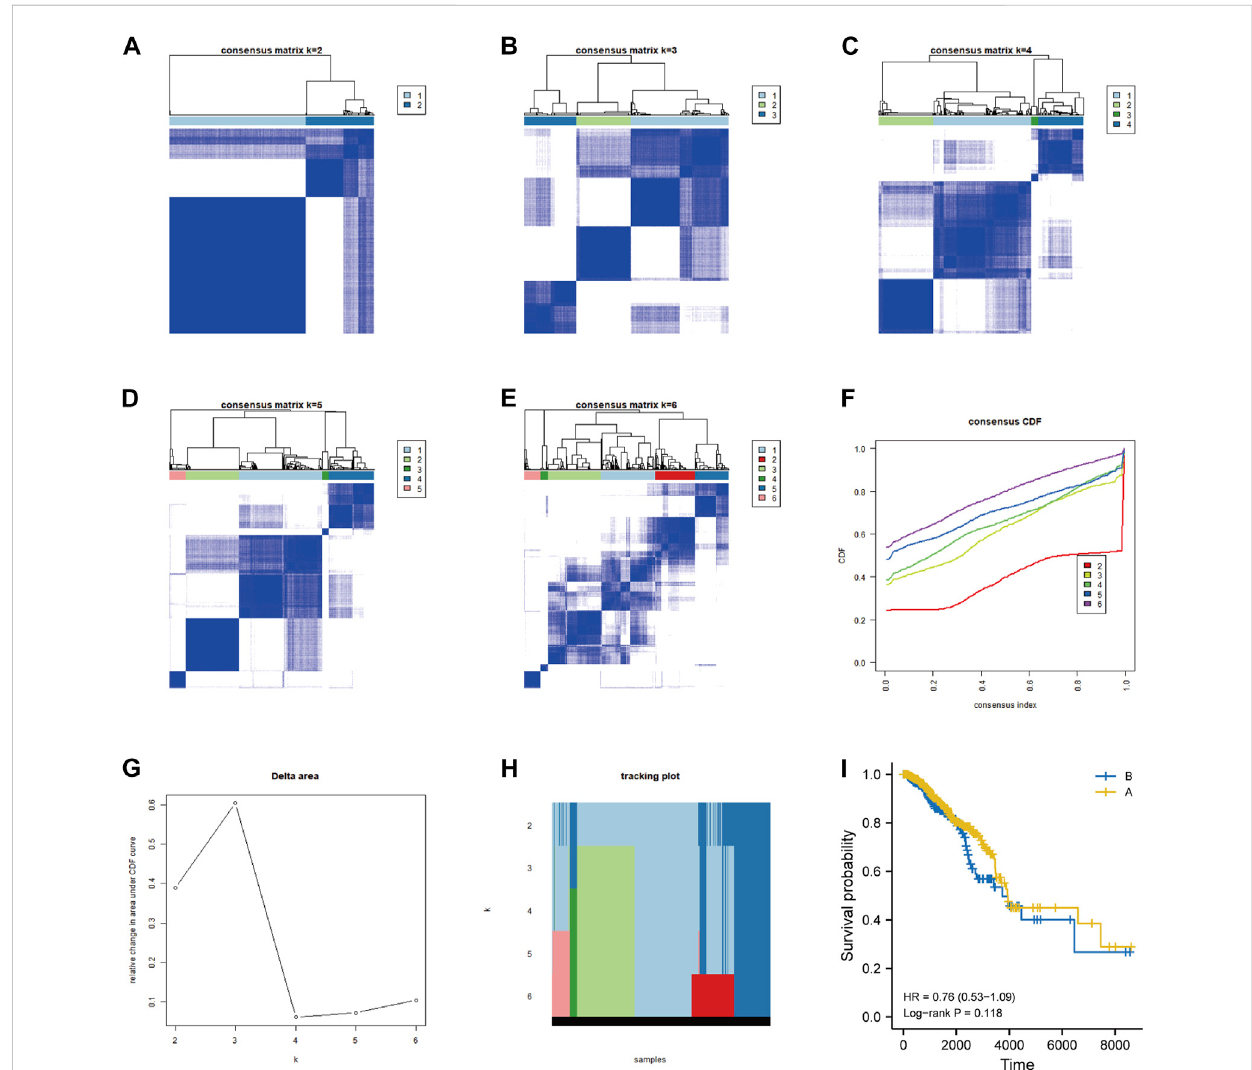
FIGURE 5 Determination of the molecular subtypes of breast cancer based on differentially expressed fatty acid metabolism-related genes. (A – H) Unsupervised consensus clustering analysis of breast cancer samples based on the differential expression of fatty acid metabolism-related genes. (I) Survival prognosis analysis of samples clustered into 2-class